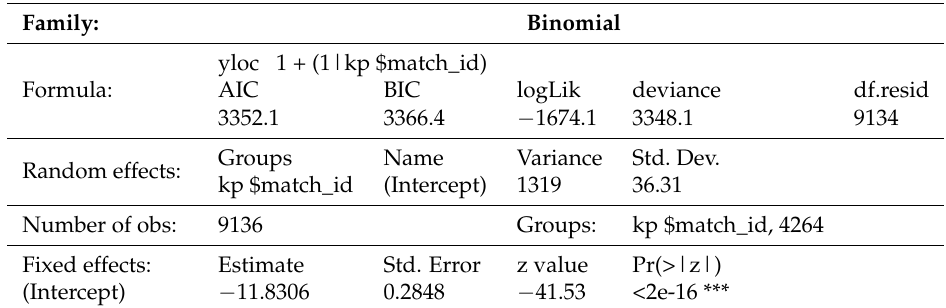
Table 3. Model 2-0: Generalized linear mixed model fit by maximum likelihood (Laplace Approximation) [’glmerMod’].